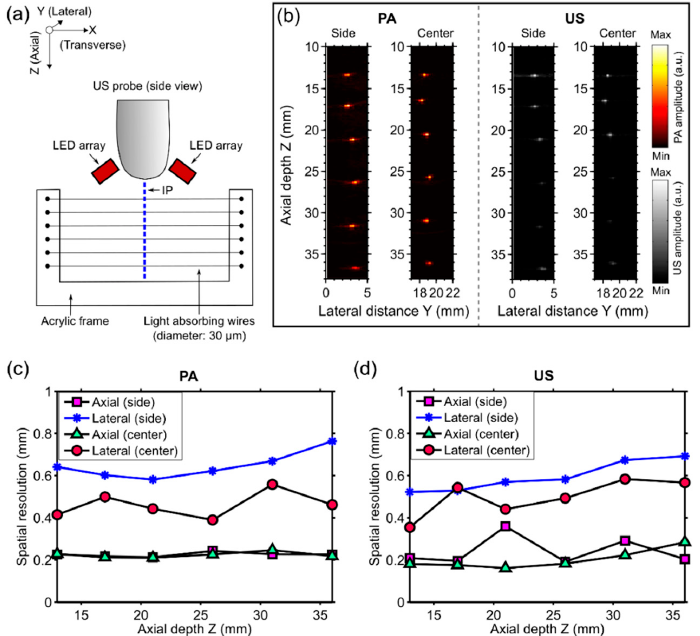
Figure 2. ( a ) Schematic illustration of the resolution phantom and the measurement geometry. The phantom, which comprised six light-absorbing wires mounted at different depths (Z) on an acrylic frame, was positioned so that these wires were perpendicular to the imaging plane (IP). LED: light-emitting diode; ( b ) Photoacoustic (PA) and ultrasound (US) images were acquired with the phantom at two different lateral (Y) positions so that the wires were near the side and the center with respect to the ultrasound imaging probe, respectively. Both PA and US images were displayed in linear scales (a.u.: arbitrary units); ( c ) Measured axial and lateral PA imaging resolution for the two lateral positions of the phantom (side and center) as a function of depth; and ( d ) the corresponding values for US imaging.